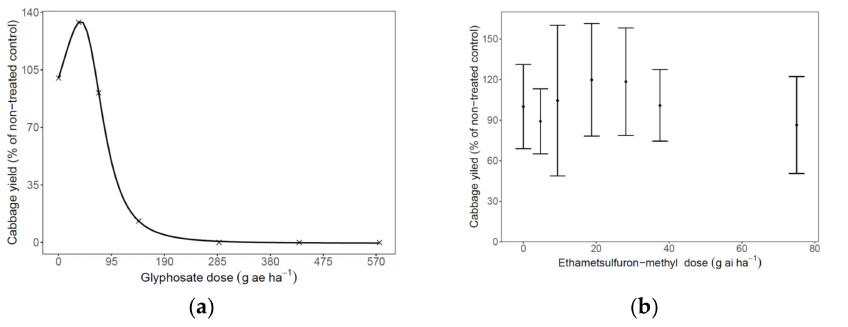
Figure 3. Sensitivity of cabbages to the herbicides glyphosate ( a ) and ethametsulfuron-methyl (EMS, b ) applied sequentially on 21, 35, and 49 DAP. ( a ) A four-parameter modified sigmoid equation (for u-shaped hormesis) was fitted to the cabbage response to glyphosate; the parameters were as follows: upper asymptote (d = 100, SE = 0.74, p ≤ 0.0001), 50% of cabbage yield (X 0 = 94.83, SE = 0.06, p ≤ 0.0001), and size of the hormesis effect (f = 11.63, SE = 0.38, p ≤ 0.0001). ( b ) Relationship between cabbage yield and EMS dose. Since there were no significant differences in the response of the cabbages to the various doses of EMS, a regression equation was not fitted.